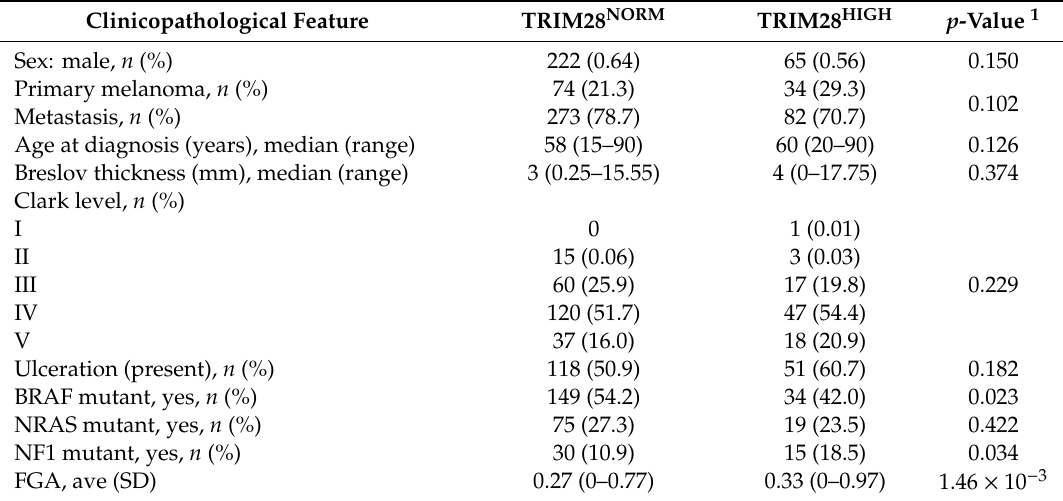
Table 1. Clinicopathological features of the SKCM TCGA patients included in the